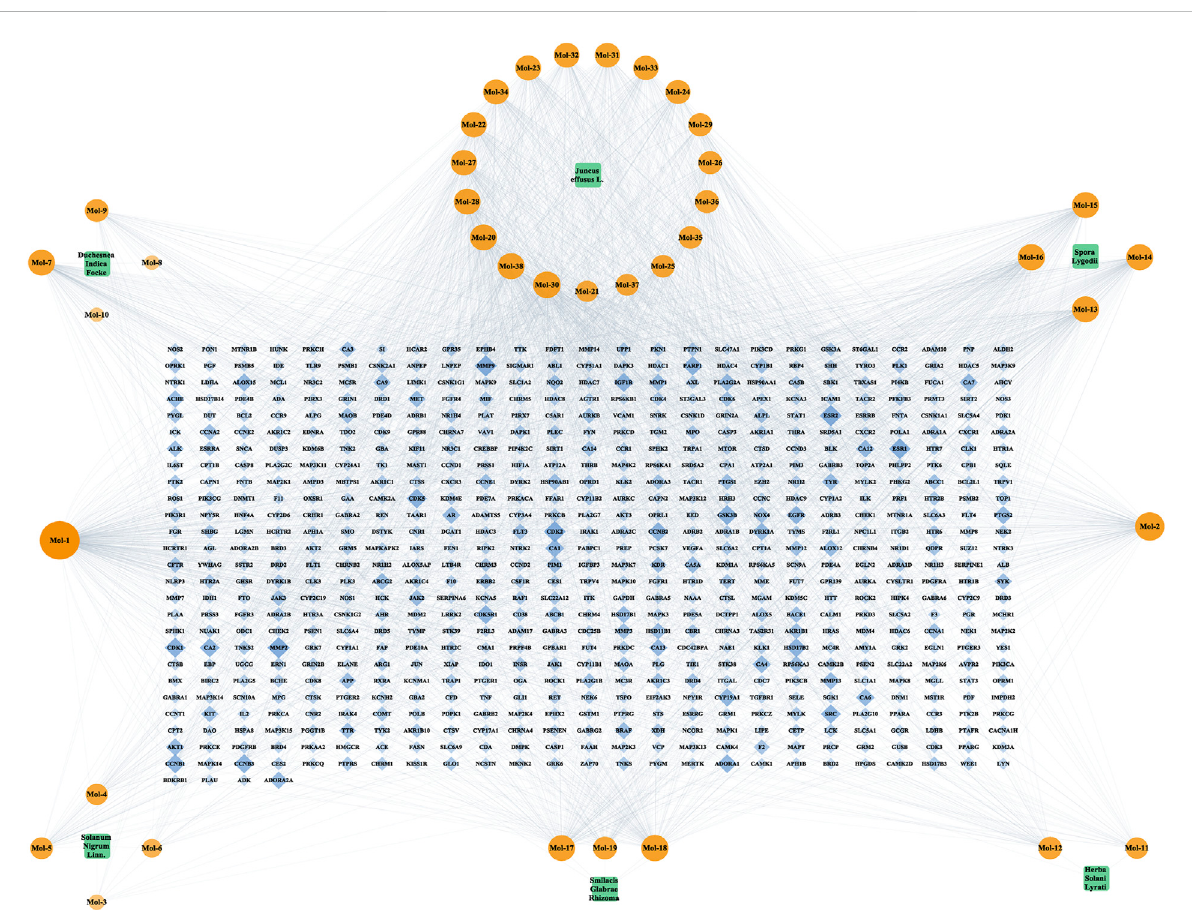
FIGURE 2 TheTCM-compound-targetnetwork with698nodesand2,861edges.TCMs,active compoundsandtargetswererepresentedbygreenround rectangular-, orange circular- and blue diamond-shaped nodes, respectively. The greater the Degree value of a node was, the larger the size and lower the transparency were in the